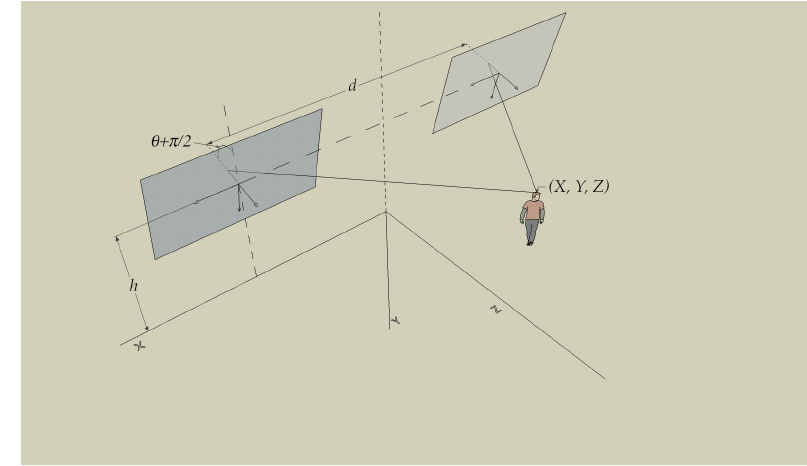
Figure 1. Pinhole vision system